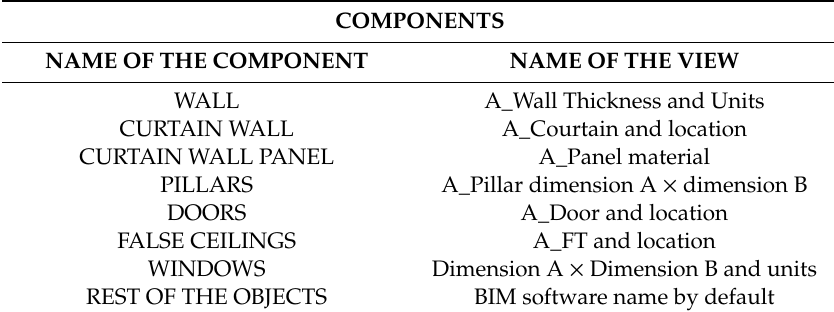
Table 2. Extract of BIM Execution Plan (BEP)